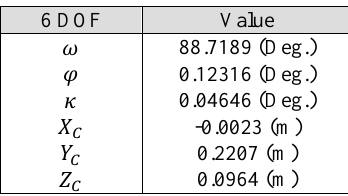
Table 4. Extrinsic parameters between TLS and digital